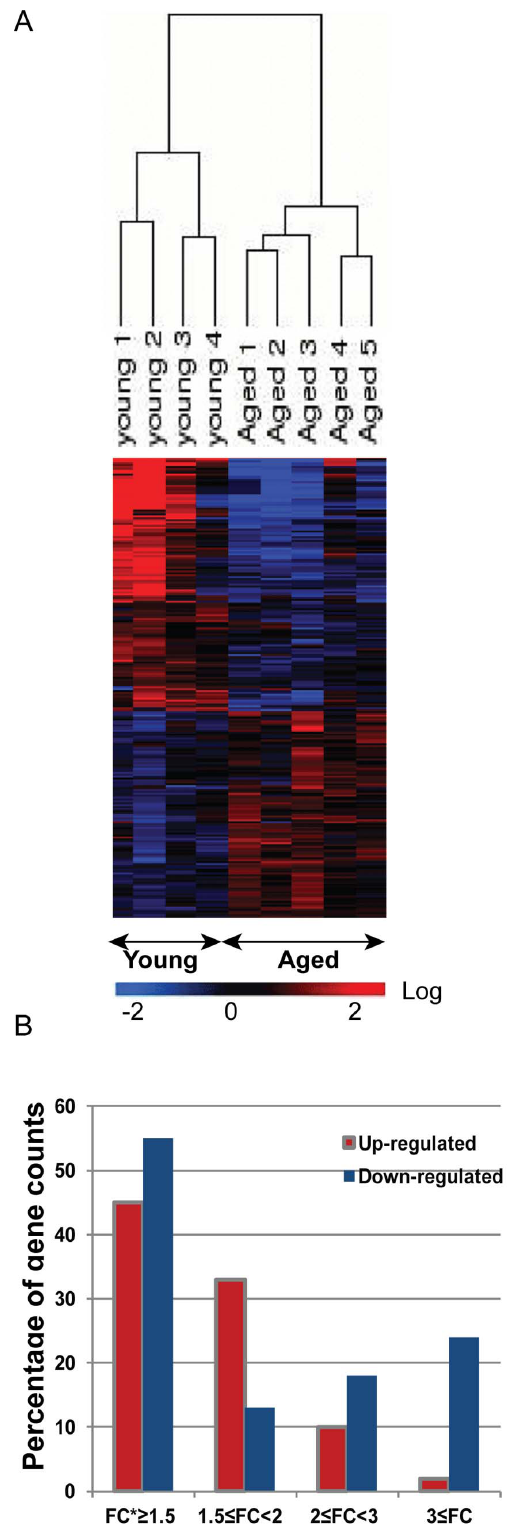
Figure 1. Clustering of Gene expression changes in young and aged MoDCs. (A) Hierarchical clustering heat map of 260 genes. with significant expression changes in young and aged MoDCs. Each column represents an individual donor; each row refers to a gene. Gene expression changes with respect to median changes across age are